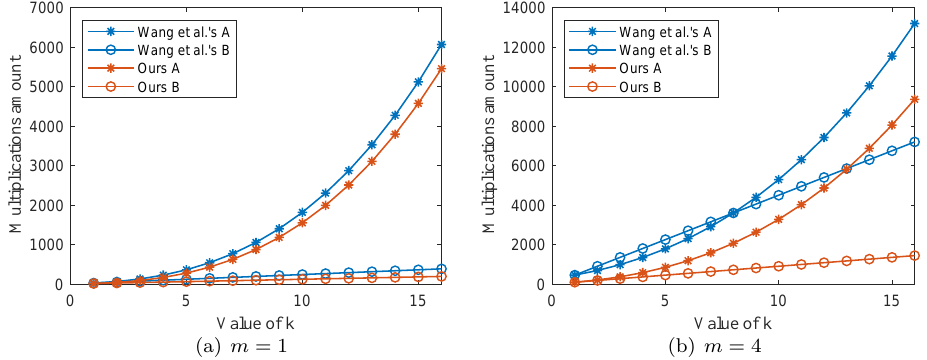
Figure 2: Comparison of the number of multiplications with increasing k for the packed operation and serial